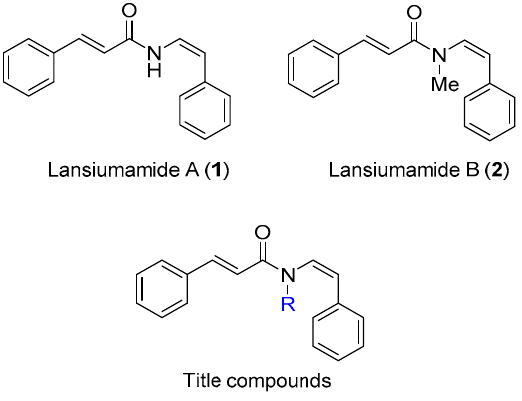
Figure 1. Lead compounds and design strategy for the title compounds.